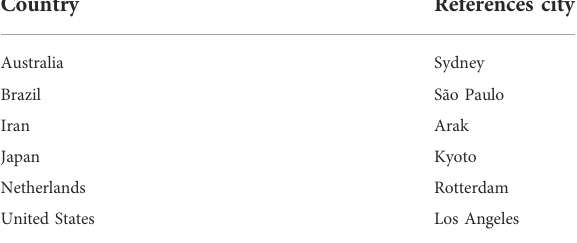
TABLE 1 List of reference cities within our case